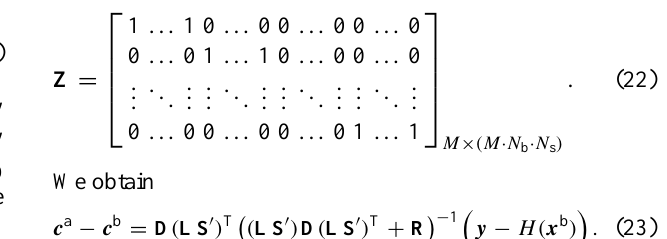
(cid:16) χ 2 = y − H( x b )